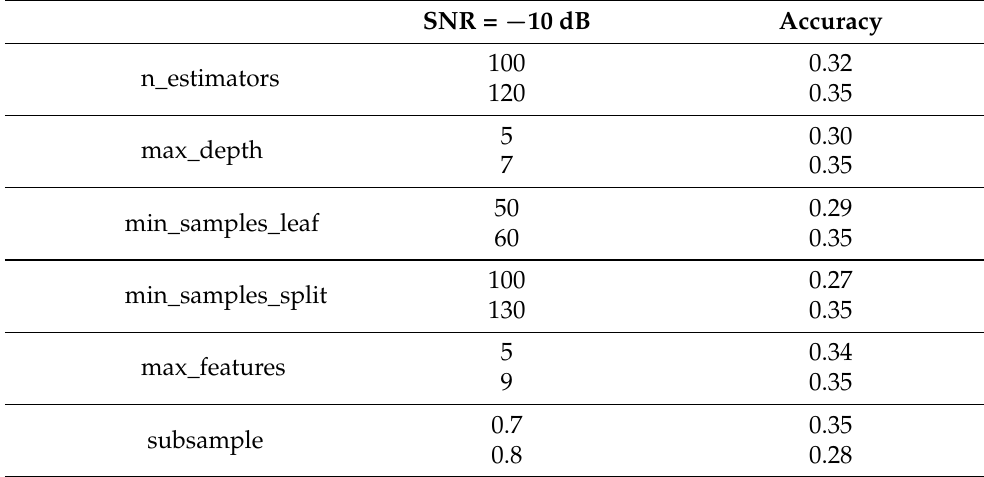
Table 2. The accuracy of GBM model parameters and related